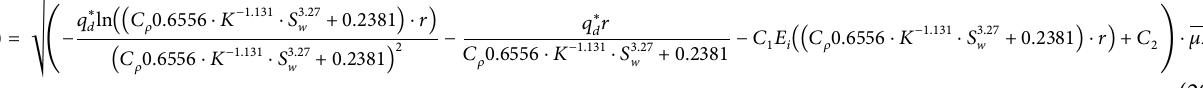
water saturation. The basic parameters used in the calculation process are all from the real values of the target block, which are shown in Table 4.